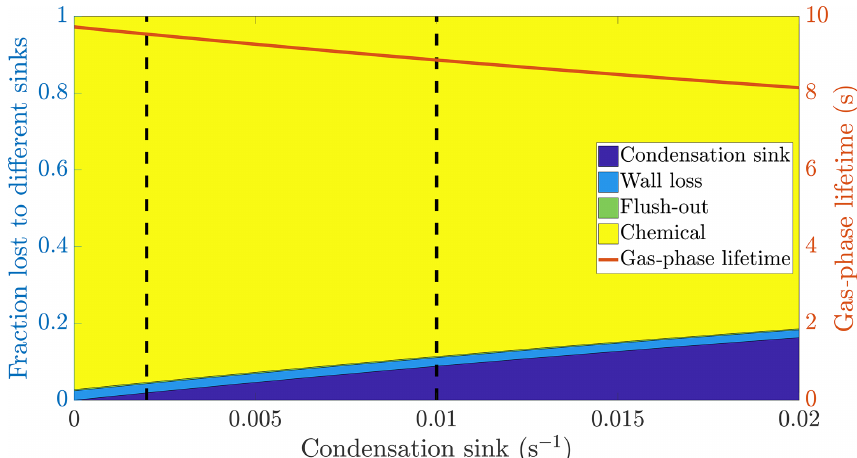
Figure A1. The calculated fraction of RO 2 radicals lost to different sinks, and their total lifetime in the gas phase as a function of the condensation sink caused by aerosol particles in the chamber. The chemical lifetime of RO 2 is estimated to be 10s, and the wall loss lifetime 400s. The vertical broken lines at 0.002 and 0.01s − 1 represent a typical situation without seed particles and with seed particles respectively.